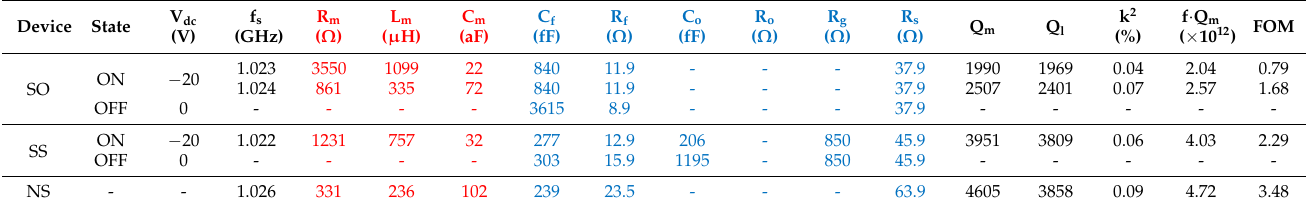
Table 2. Fitting parameters of the switchable transducers without control gate in ON/OFF states along with their non- switchable counterparts extracted from equivalent circuit models shown in Figure 6. Color coding coincides with the circuits shown in Figure 6.